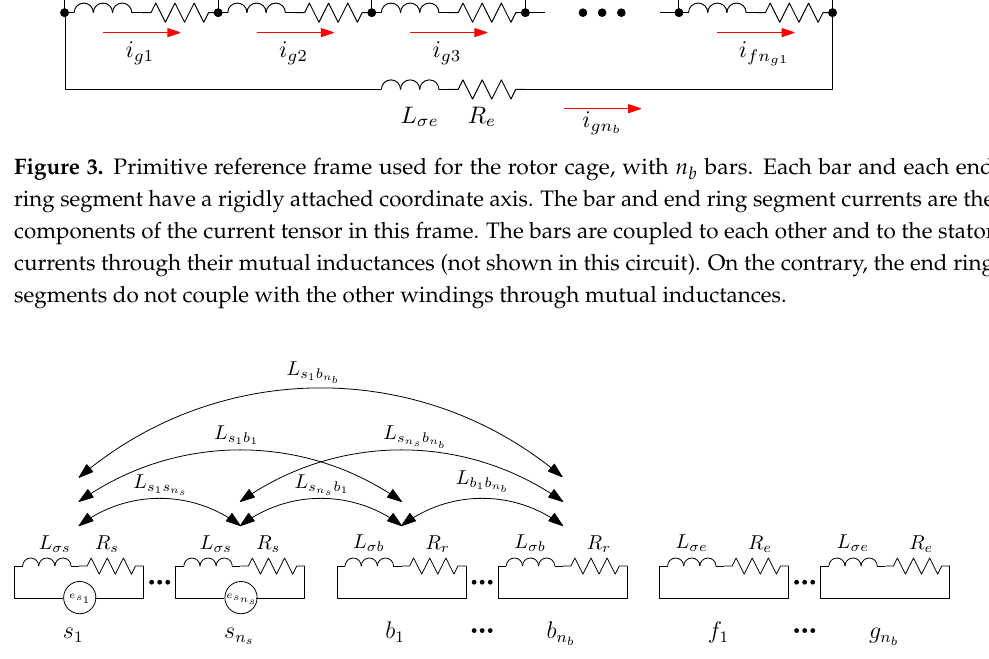
Figure 4. Primitive reference frame of the SCIM, found by removing all interconnections between the windings, and short circuiting each. The arrows show the mutual impedances between stator windings and cage bars. The end ring segments do not couple with the other windings through mutual